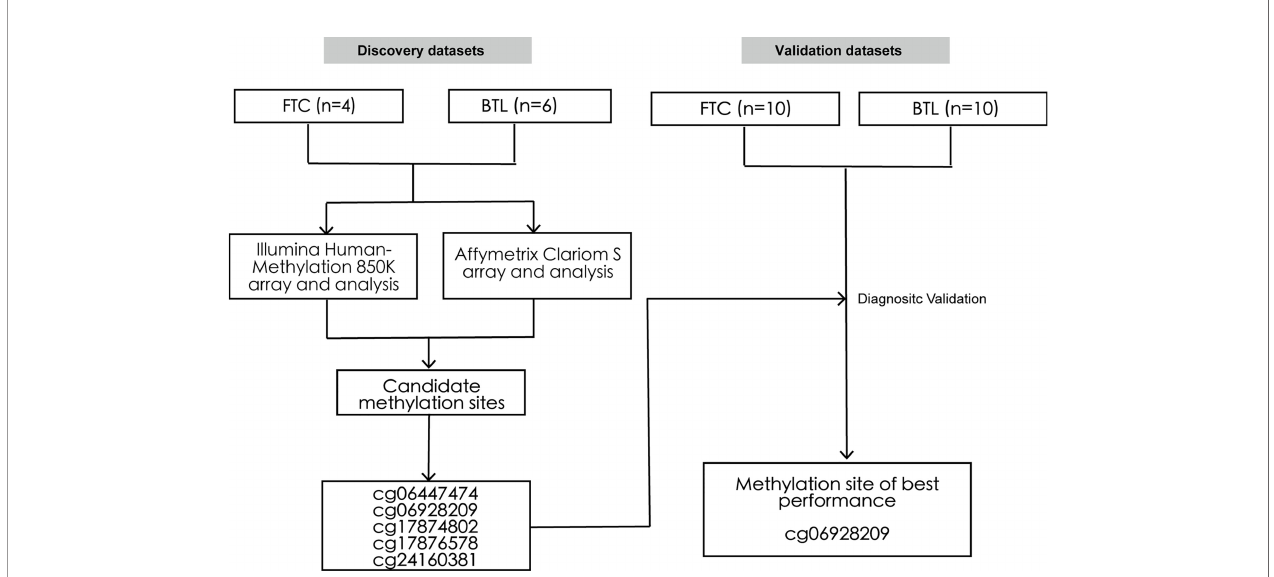
FIGURE 1 | Study design. The schematic diagram represents the strategy for discovery and validation of the FTC-speci fi c methylated sites for preoperative diagnosis. FTC, Follicular thyroid carcinoma; BTL, Benign thyroid